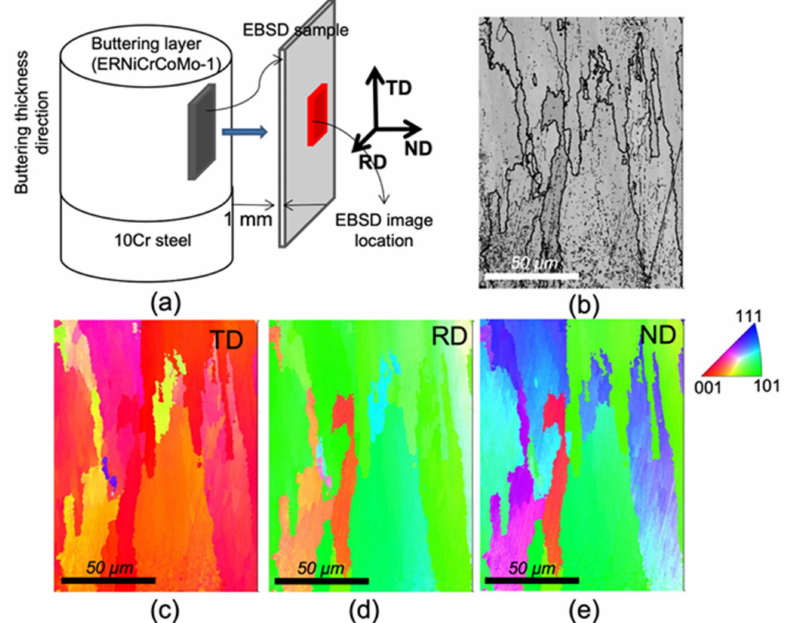
Figure 4. EBSD images and grain orientation: ( a ) schematic of the sample extracted for the EBSD study and EBSD image location in the buttering layer, ( b ) image quality map, and ( c – e ) in- verse pole figure (IPF) maps corresponding to the buttering thickness, circumferential and radial directions, respectively.